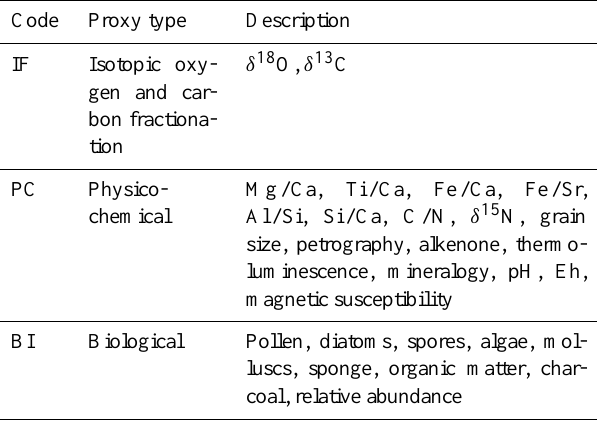
Table 1. Description of proxy types used in this study (modified from Wirtz et al.,